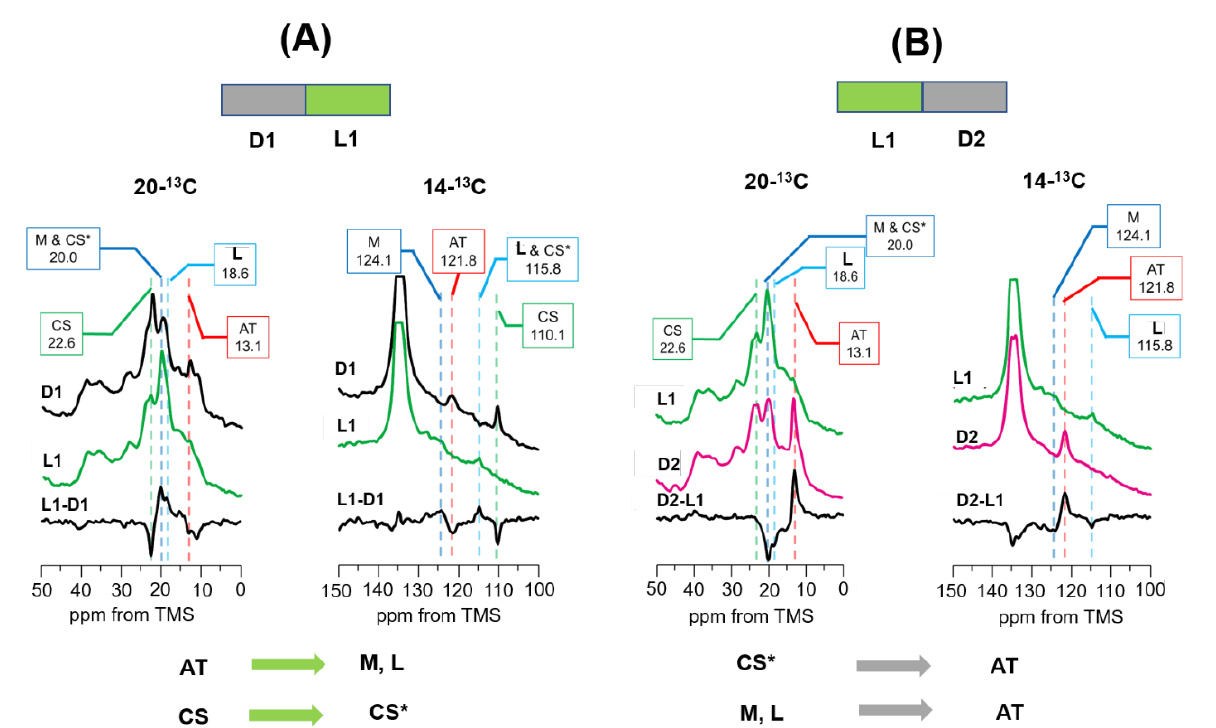
Figure 5. ( A ) Photoreaction pathways of [20- 13 C, 14- 13 C]retinal-D96N-BR under green light (520 nm) illumination at − 30 ◦ C. 13 C CP-MAS NMR spectra were recorded in the dark (D1; 20- 13 C and 14- 13 C) and then under green light (L1; 20- 13 C and 14- 13 C), and the difference in spectra between L1 and D1 (L1-D1; 20- 13 C and 14- 13 C) indicated that the AT state changed to the M and L intermediates and the CS state changed to the CS* intermediate. ( B ) Photo reaction pathway of [20- 13 C, 14- 13 C]retinal-D96N-BR in the dark after green light illumination at − 30 ◦ C. 13 C CP-MAS NMR spectra were recorded under green light (L1; 20- 13 C and 14- 13 C) and then in the dark (D2; 20- 13 C and 14- 13 C), and the difference in spectra between D2 and L1 (D2-L1; 20- 13 C and 14- 13 C) indicated that the CS* intermediate changed to the AT state and the M and L intermediates changed to the AT